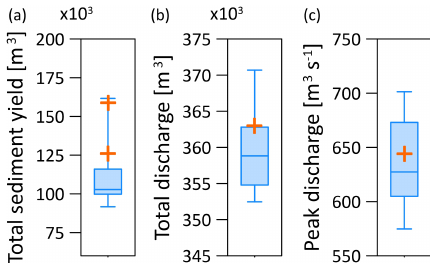
Figure 7. Box plots showing the median (horizontal line), 25th– 75th percentile range (shaded area), and maximum and minimum range (bounded with lines) of the total sediment yield (a) , total streamflow volume (b) , and peak streamflow (c) from the 10 down- scaled spatial rainfall realizations for the heavy rainfall event of Au- gust 2005. The orange “ + ” symbols represent the observed data for the total and peak streamflow and the estimated range of the total sediment